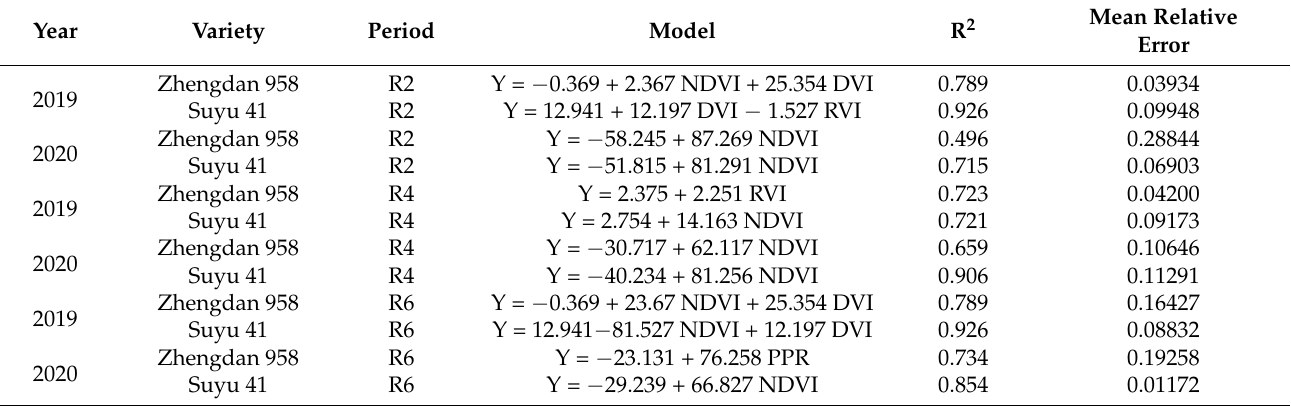
Table 7. Construction of GY model for different growth periods of summer maize in 2019 and